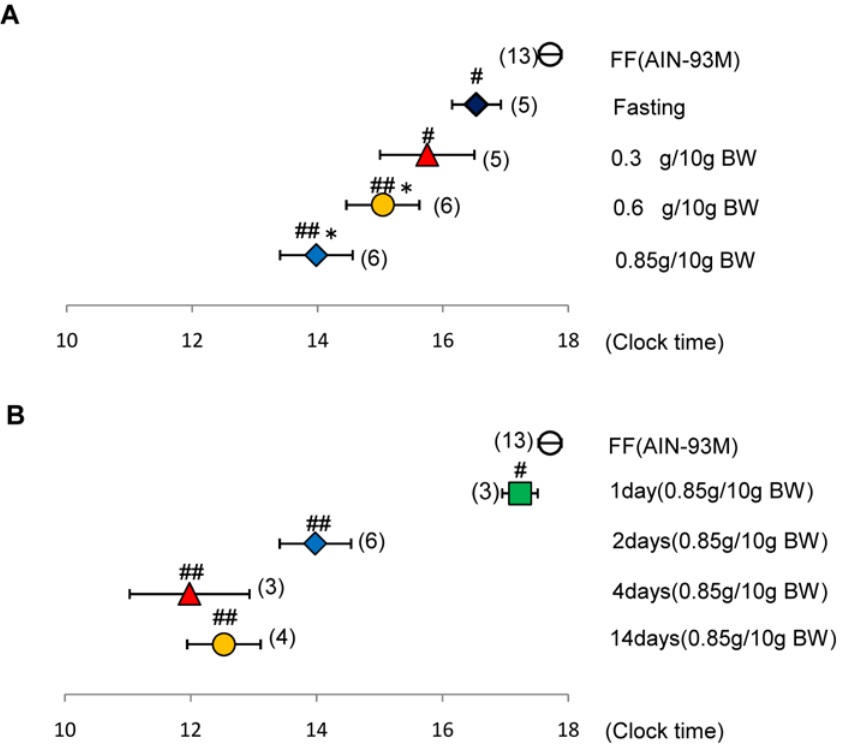
Figure 1. Effects of food volume and daily meal on the phase of the liver circadian clock. A: Mice were administered a diet tablet containing 0–0.85 g/10 g BW of the control AIN-93M diet for 2 days after 24-h food deprivation. Diet volume of 0.3 g/10 g BW for 2 days (0.3 + 0.3-g group); 0.6 g/10 g BW for 2 days (0.6 + 0.6-g group); or 0.6 g/10 g BW on the first day and 0.85 g/10 g BW on the second day (0.6 + 0.85-g group) was administered. B: Diets of 0.6 g/10 g BW on the first day (1-day group); 0.6 g/10 g BW on the first and 0.85 g/10 BW on the second day (2-day group); or 0.6 g/10 g BW on the first day followed by 0.85 g/10 g BW for the next 3 days (4-day group) was administered. Some mice were permitted free access to the control diet during ZT6–ZT10 (4 h) for 14 days (14-day group). The values indicate the mean 6 SEM. The horizontal axis indicates the projected zeitgeber time (pZT) at the peak of the bioluminescence rhythm. ZT0 is light-on time in the housing room prior to sacrifice of the mice. Fisher’s PLSD test: # P , 0.05, ## P , 0.01 (vs. free feeding). * P , 0.05 (vs. fasting). Two kinds of control experiments were prepared: Free feeding (open circle); fasting, 2-day fast (rhombus). The numbers in the parentheses indicate the number of tested mice.